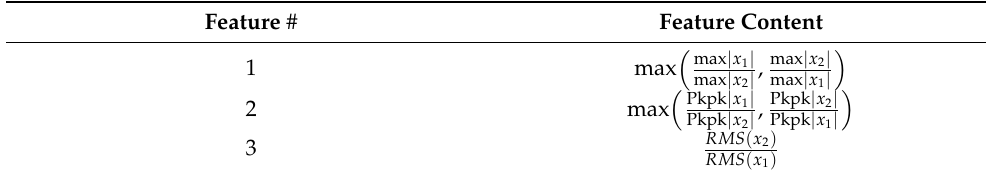
Table 1. Features extracted from the received time-domain waveforms x 1 and x 2 ; these are recorded by two receivers forming a symmetric pair